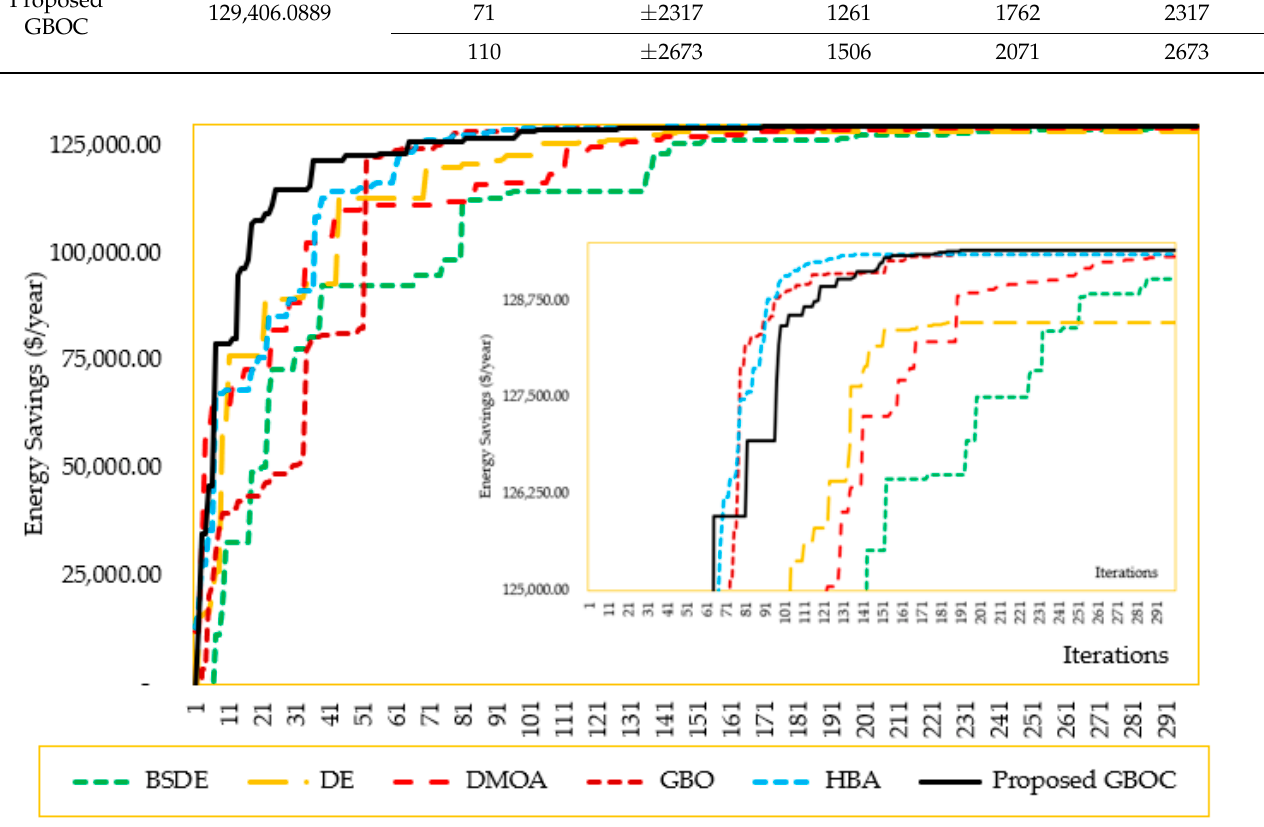
Figure 21. Convergence characteristics of GBOC, GBO, SSA, DMOA, DE, and HBA for the IEEE 119- distribution system.